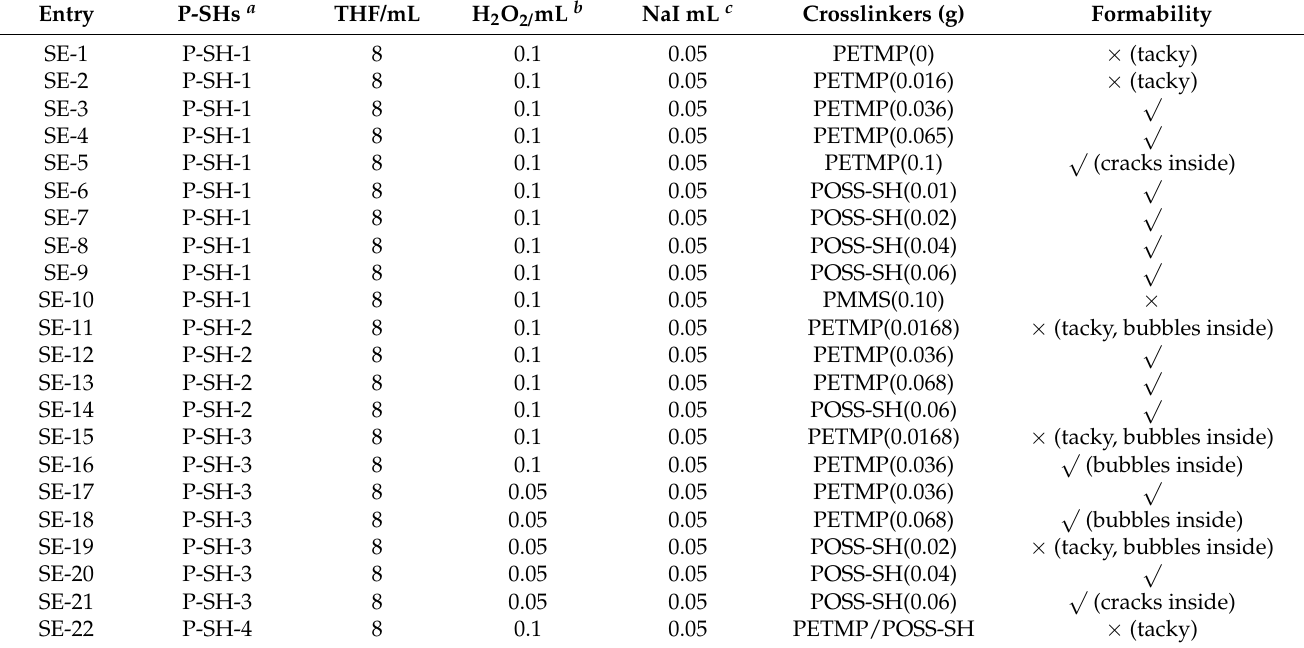
Table 1. Experimental data on the preparation of silicone elastomers under different